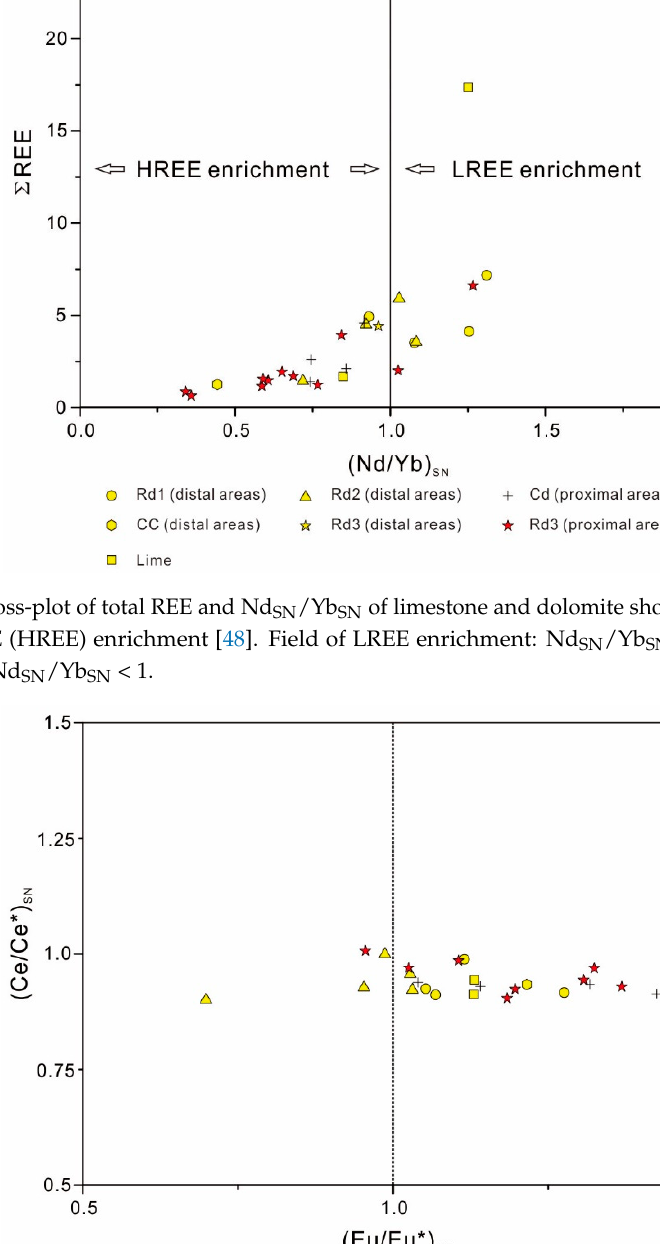
Figure 15. Post-Archean average shale (PAAS)-normalized rare earth element (REE) patterns of limestone and dolomites. The PAAS data were obtained from McLennan (1989) [35].